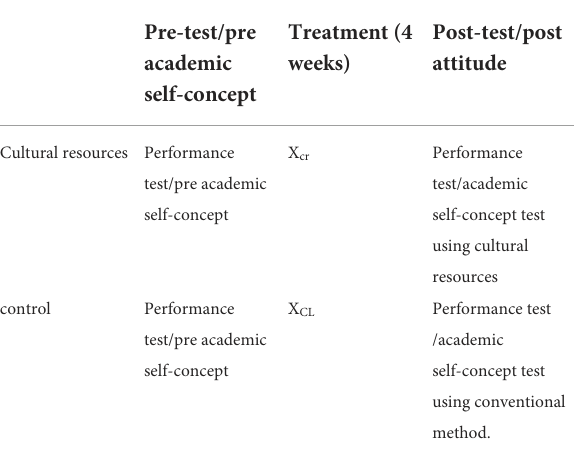
TABLE 1 The study